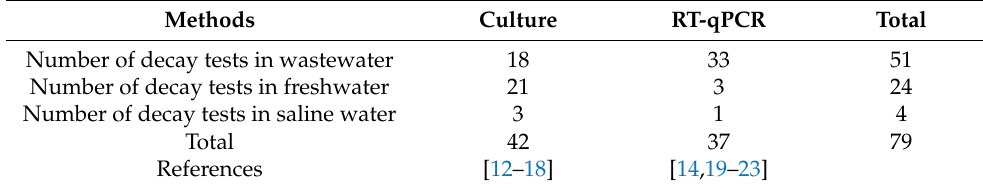
Table 1. Summary of identified decay tests of coronavirus in different water types.